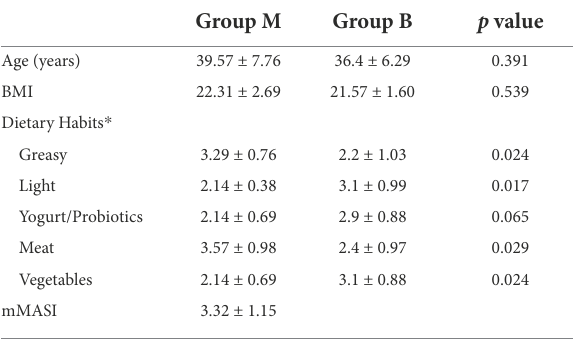
TABLE 1 Characteristics of patients with melasma and